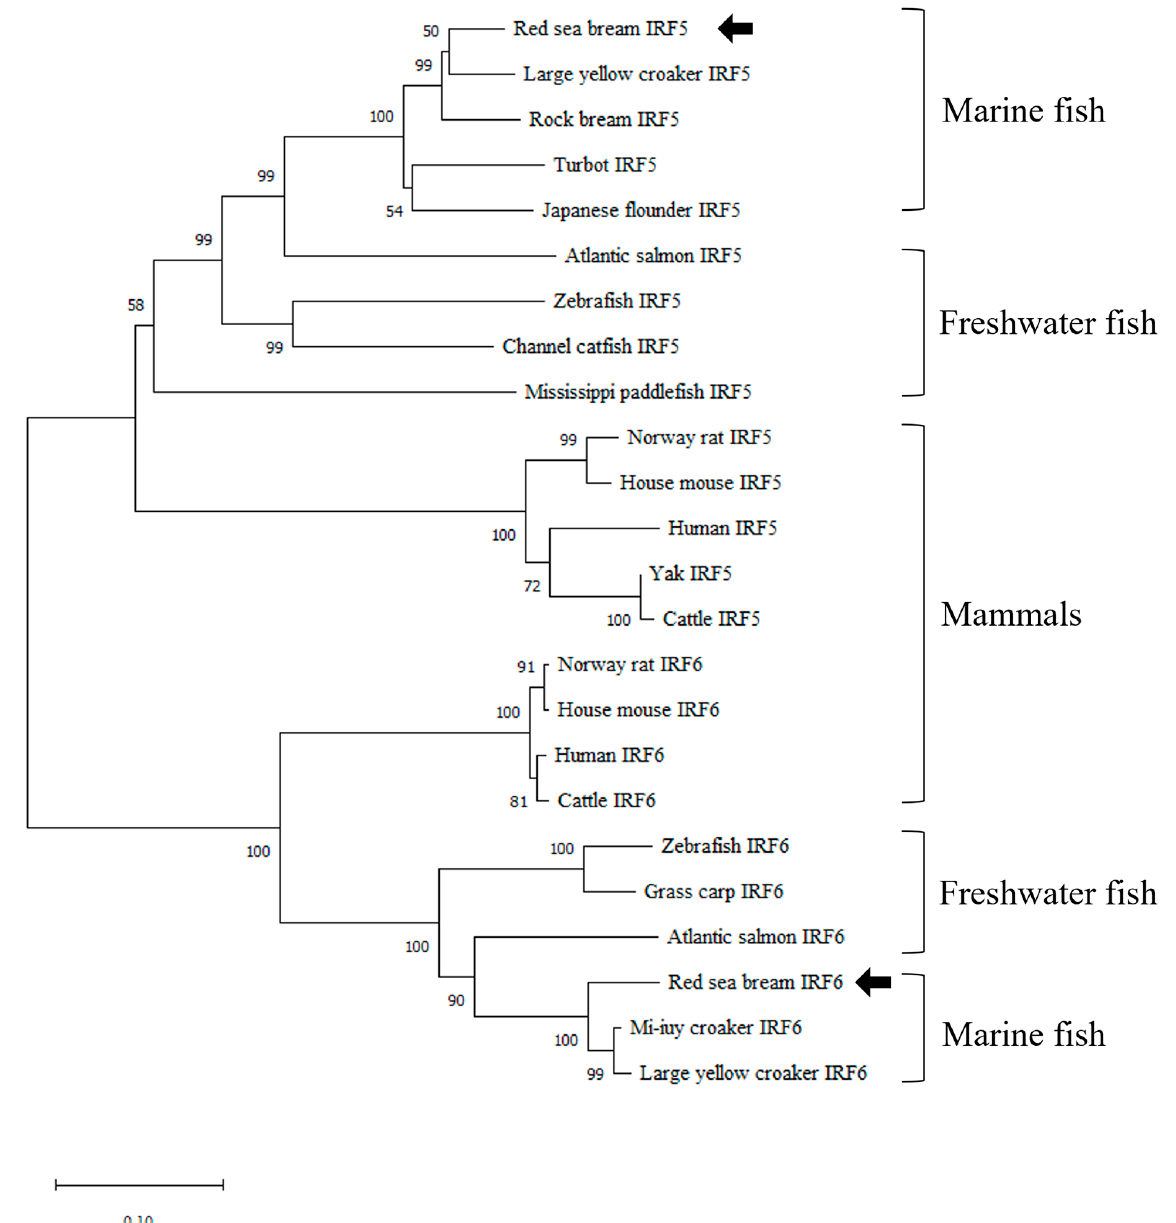
Figure 2. A phylogenetic tree of P. major interferon regulatory factor ( PmIRF5 ), PmIRF6 , and other known IRF5 and IRF6 homologs based on the neighbor-joining (NJ) method. The scale bar indicates a branch length of 0.10. Numbers are bootstrap percentiles from 2000 replicates. This analysis is based on the following sequence data: Red sea bream IRF5 (UIR15468), Large yellow